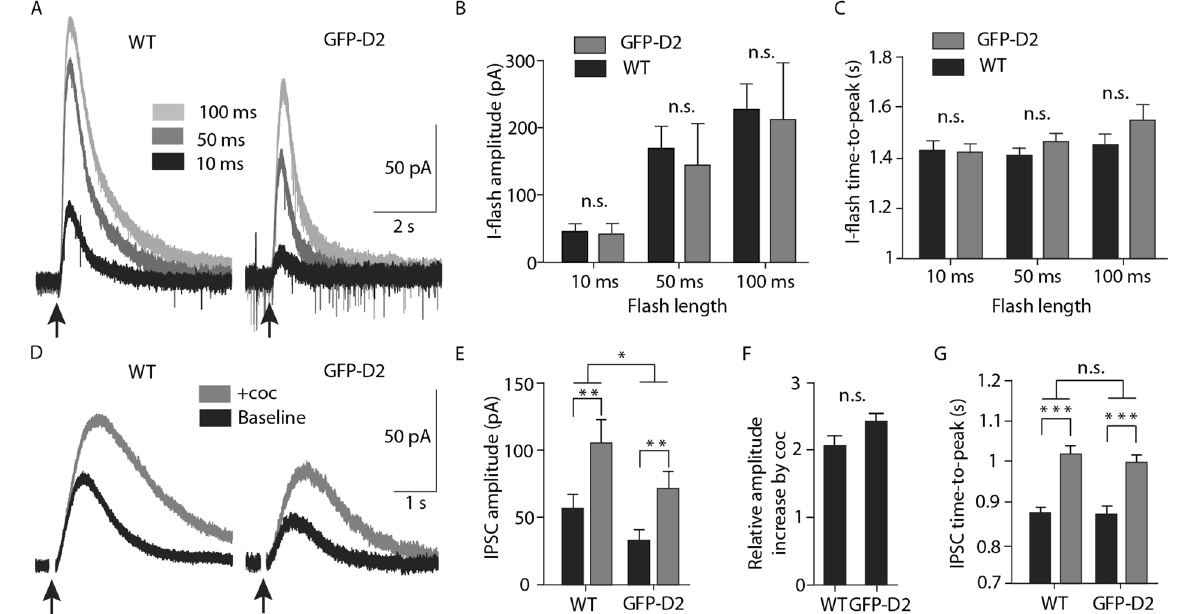
Figure 4. Signaling kinetics of the GFP-D2 resemble that of wild type D2 receptor. ( A ) Representative traces following the full-field LED uncaging (10, 50, 100 ms flashes) of dopamine onto wild type and GFP-D2 neurons. ( B ) The amplitude following dopamine uncaging did not differ between wild type and GFP-D2 at any of the flash lengths (n = 7 and 6, two-way ANOVA followed by Bonferroni). ( C ) The time-to-peak of the uncaged dopamine-induced currents were not significantly different between wild type and GFP-D2 (n = 7 and 6, two-way ANOVA followed by Bonferroni). ( D ) Representative traces of electrically stimulated D2-receptor mediated IPSCs from wild type and GFP-D2. Baseline IPSCs (black) are compared with those following the bath application of the DAT inhibitor cocaine (1 µ M, gray). ( E,F ) Overall, the wild type IPSCs were larger than the GFP-D2. The amplitude of both the wild type and GFP-D2 IPSCs increased following cocaine application and the relative increase by cocaine was similar for wild type and GFP-D2 (n = 7 and 8, two-way ANOVA followed by Bonferroni, and unpaired t test). ( F ) The time-to-peak of wild type and GFP-D2 IPSCs both significantly increased following cocaine, and there was no overall difference between the wild type and GFP- D2 groups (n = 7 and 8, two-way ANOVA followed by Bonferroni). n.s. denotes not significant, * p < 0.05, ** p < 0.01, *** p <